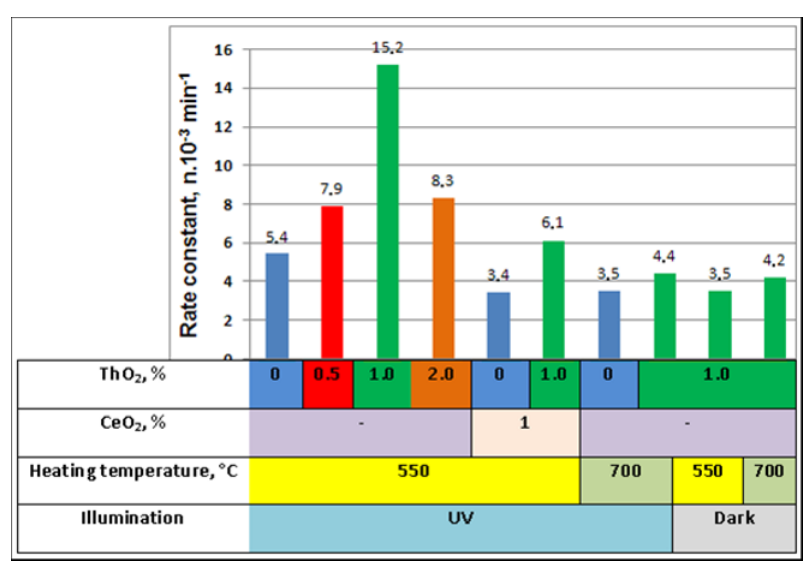
Figure 2. Photocatalytic degradation rate constant in dependence on the catalyst composition and heating temperature at its